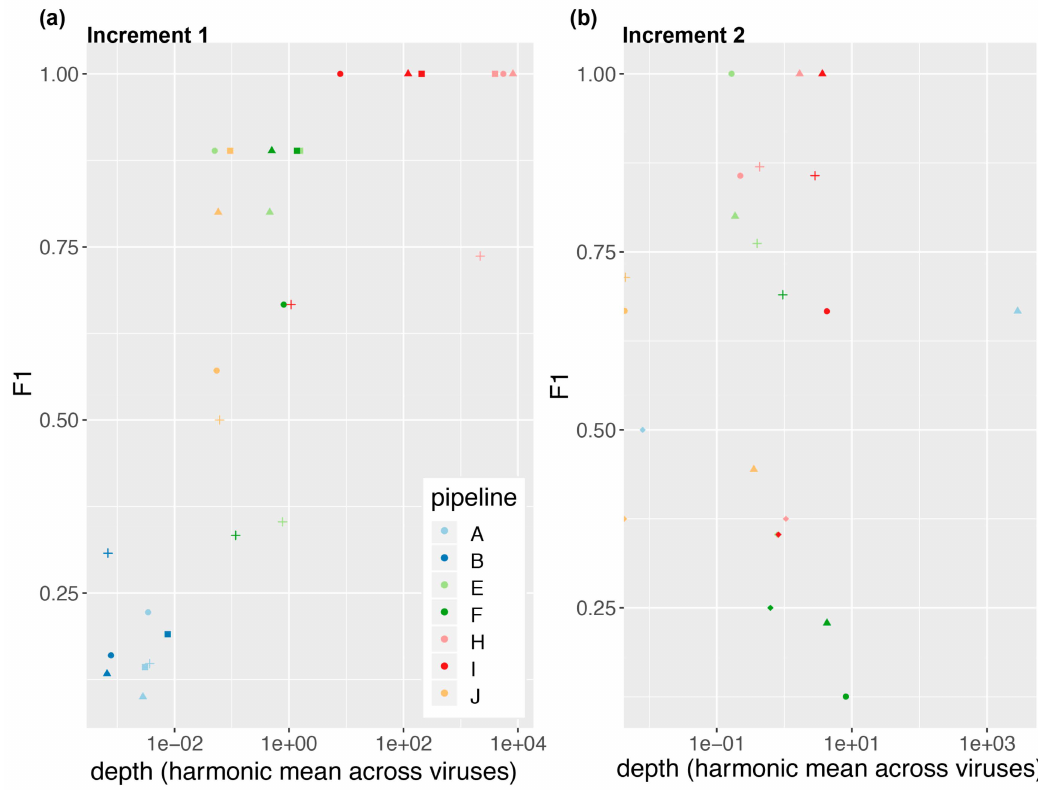
Figure 2. Performance as a function of depth (Equation (1)) for ( a ) increment 1 and ( b ) increment 2. We show here the results when participants used the SIB-provided common database. Markers represent the samples: Plasma_spike_1-1 (square); plasma_spike_1-10 (triangle); plasma_spike_1-100 (circle); NIBSC_multiplex (cross and diamond (note: In increment 2, NIBSC_multiplex was present in duplicate, cf. Materials and